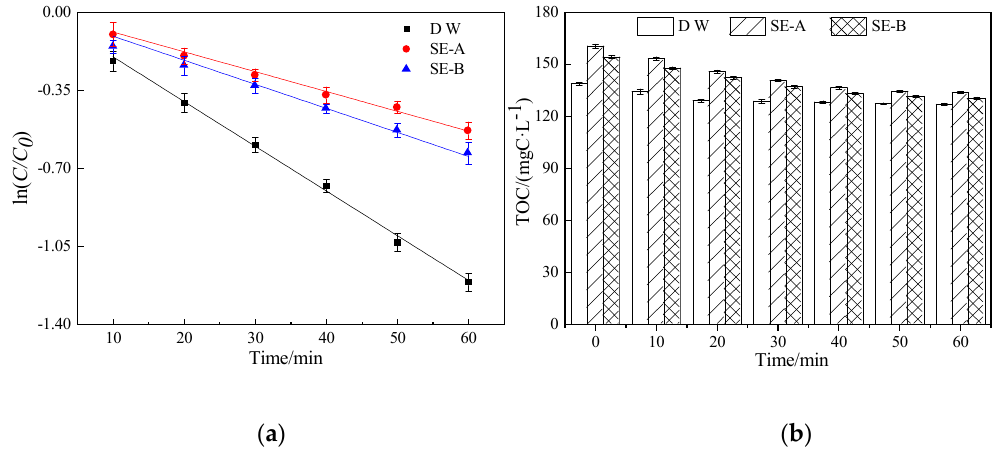
Figure 3. The effect on DCF degradation and changes of TOC in the photocatalytic process in SE-A and SE-B. ( a ) shows photocatalytic degradation rates of DCF in three different background solutions. ( b ) shows the changes of TOC during photocatalysis.